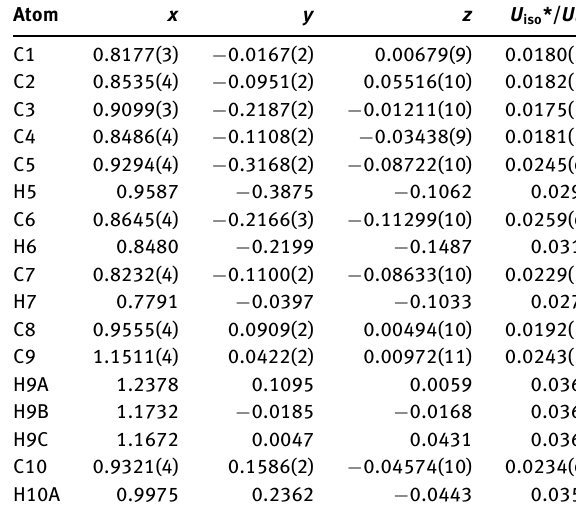
Table 2: Fractional atomic coordinates and isotropic or